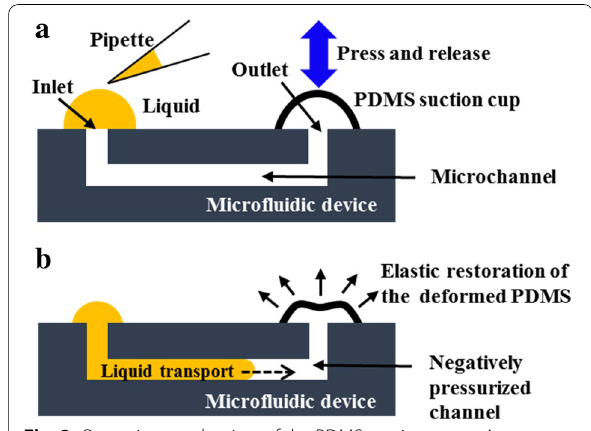
Fig. 2 Operation mechanism of the PDMS suction cup. a A user places the PDMS suction cup at the outlet of the device and presses it to deform, which negatively pressurizes the channel. b Liquid is continuously pumped through the channel by the elastic restoration of the deformed PDMS suction cup